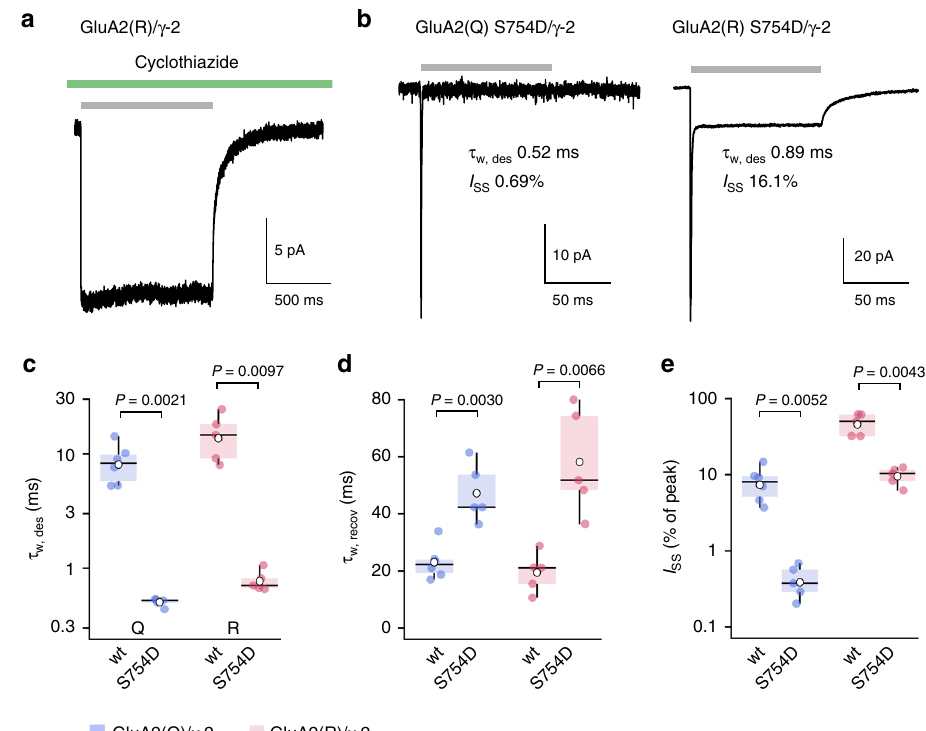
Fig. 4 Large steady-state GluA2(R)/ γ -2 currents are observed even in conditions favoring desensitization. a Representative GluA2(R)/ γ -2 current ( – 60 mV) evoked by 10 mM glutamate (gray bar) in the presence of 50 µ M cyclothiazide (green bar). Note the minimal current decay when desensitization is inhibited (for pooled data I SS / I peak = 93.4 ± 1.6%, n = 6) (mean ± s.e.m. from n patches). b Representative glutamate-evoked currents from Q- and